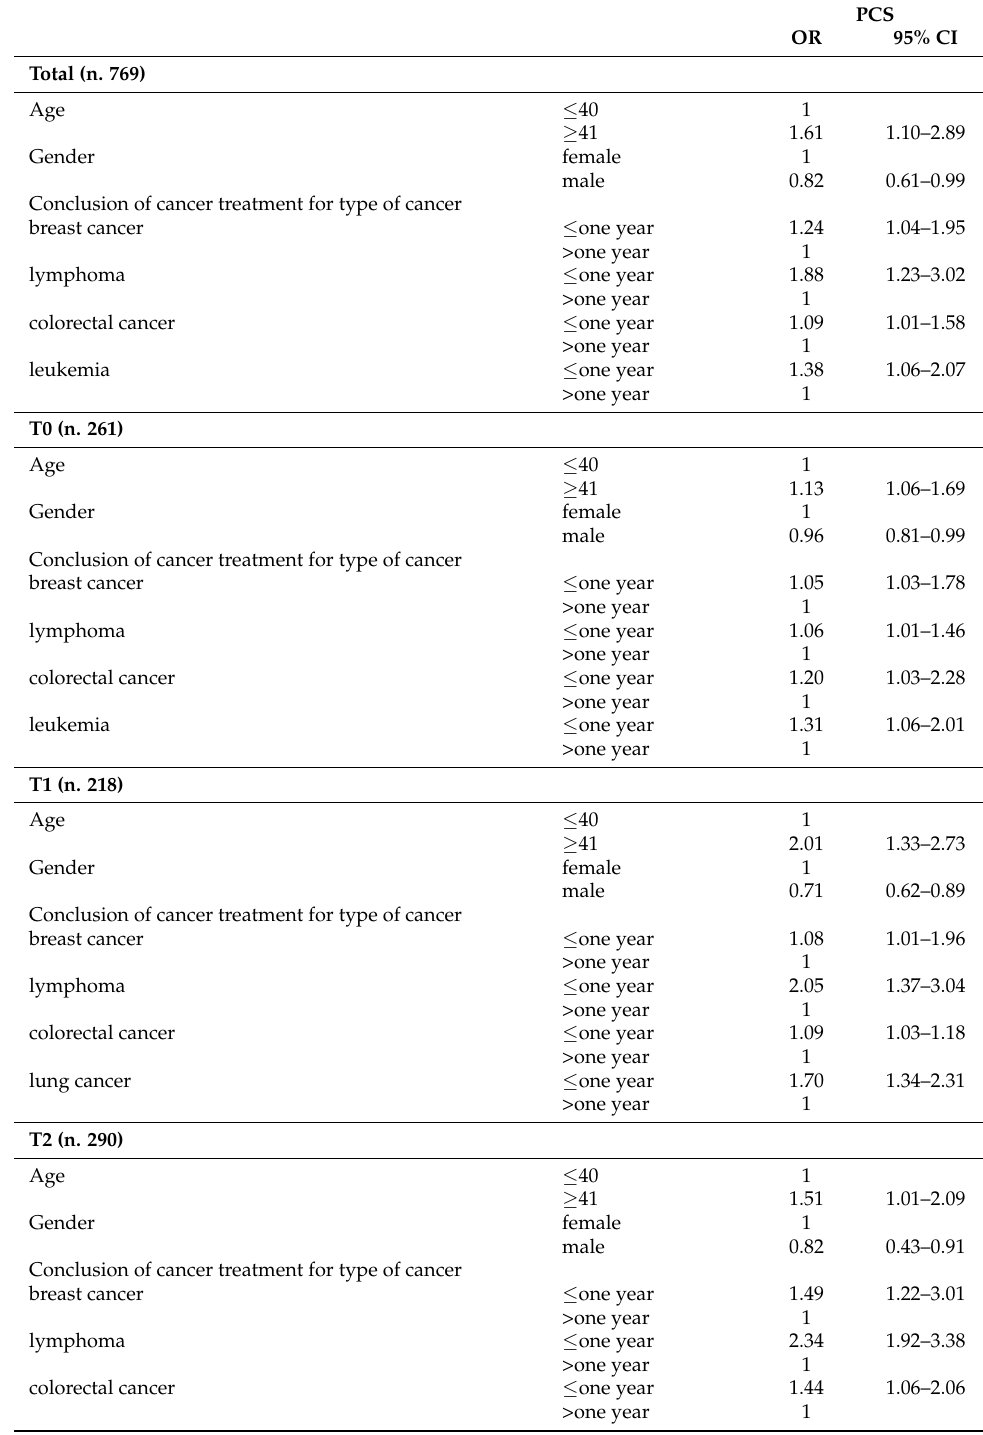
Table 5. Logistic regression model relating groups of variables and